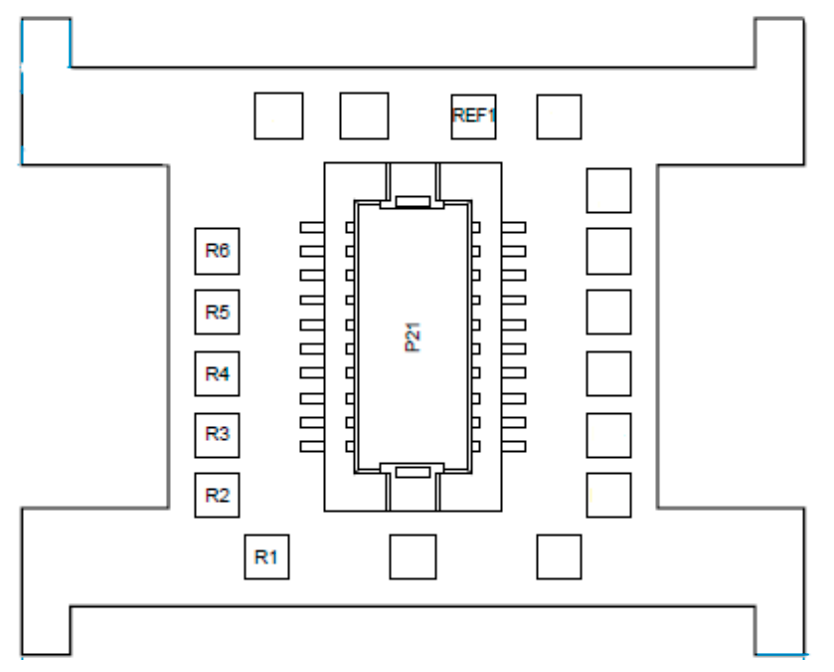
Figure 2. Electronic interface board (EIB) microchip schematic showing six referential channels for electroencephalograph (EEG) output (R1–R6) and one reference channel (REF1). P21 is the site in which the logger device was connected to the implant.